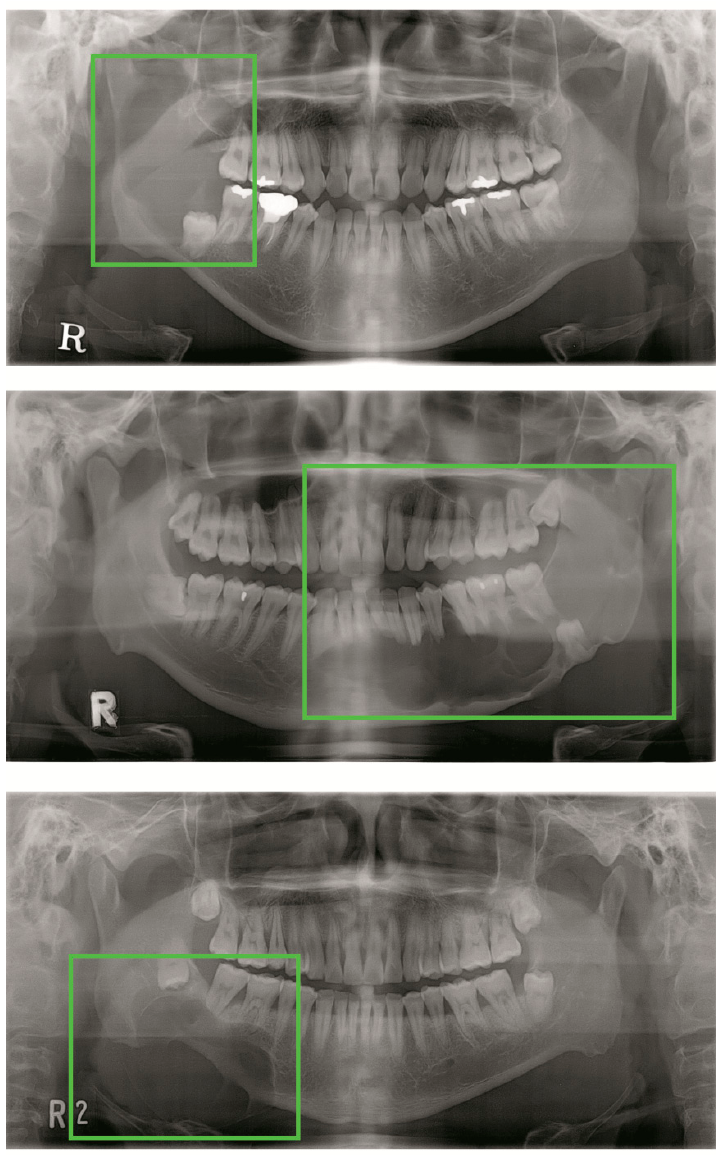
Figure 7. Undetected large lesions.